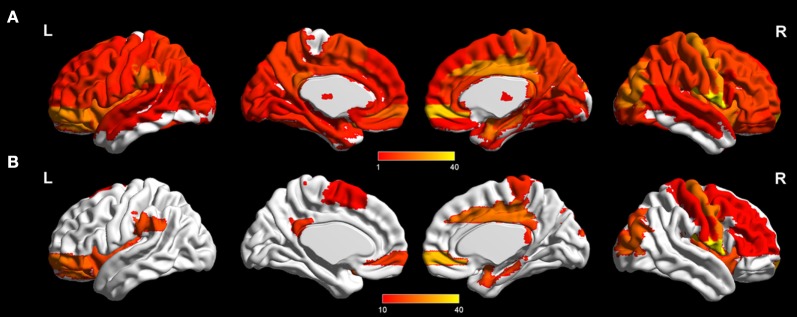
Significant difference in terms of functional connections between groups as determined by one-way ANOVA (network-based statistics corrected, p < 0.01). (A) Significant brain network nodes are rendered on the surface of automated anatomical labeling atlas in BrainNet Viewer (NKLCNL, Beijing Normal University). The color code represents the number of significant connections of the given regions of interest. (B) Significant cortical and subcortical nodes with a number of significant connections higher than 10 are displayed.